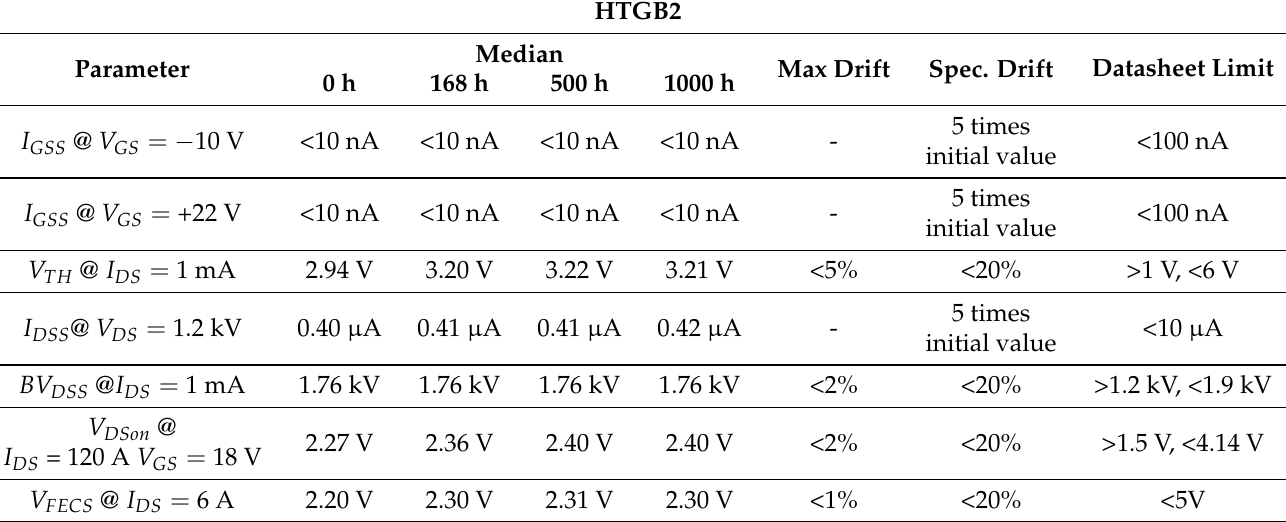
Table 7. Drifts of some GEN3 SiC MOSFET electrical parameters for the HTGB2